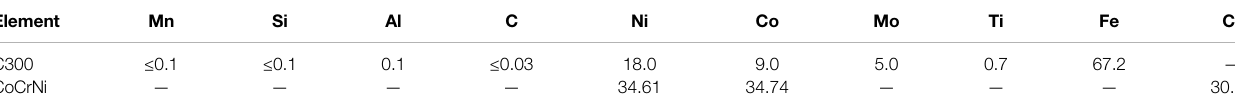
TABLE 1 | The chemical composition of C300 maraging steel and CoCrNi medium-entropy alloy (wt%). Element